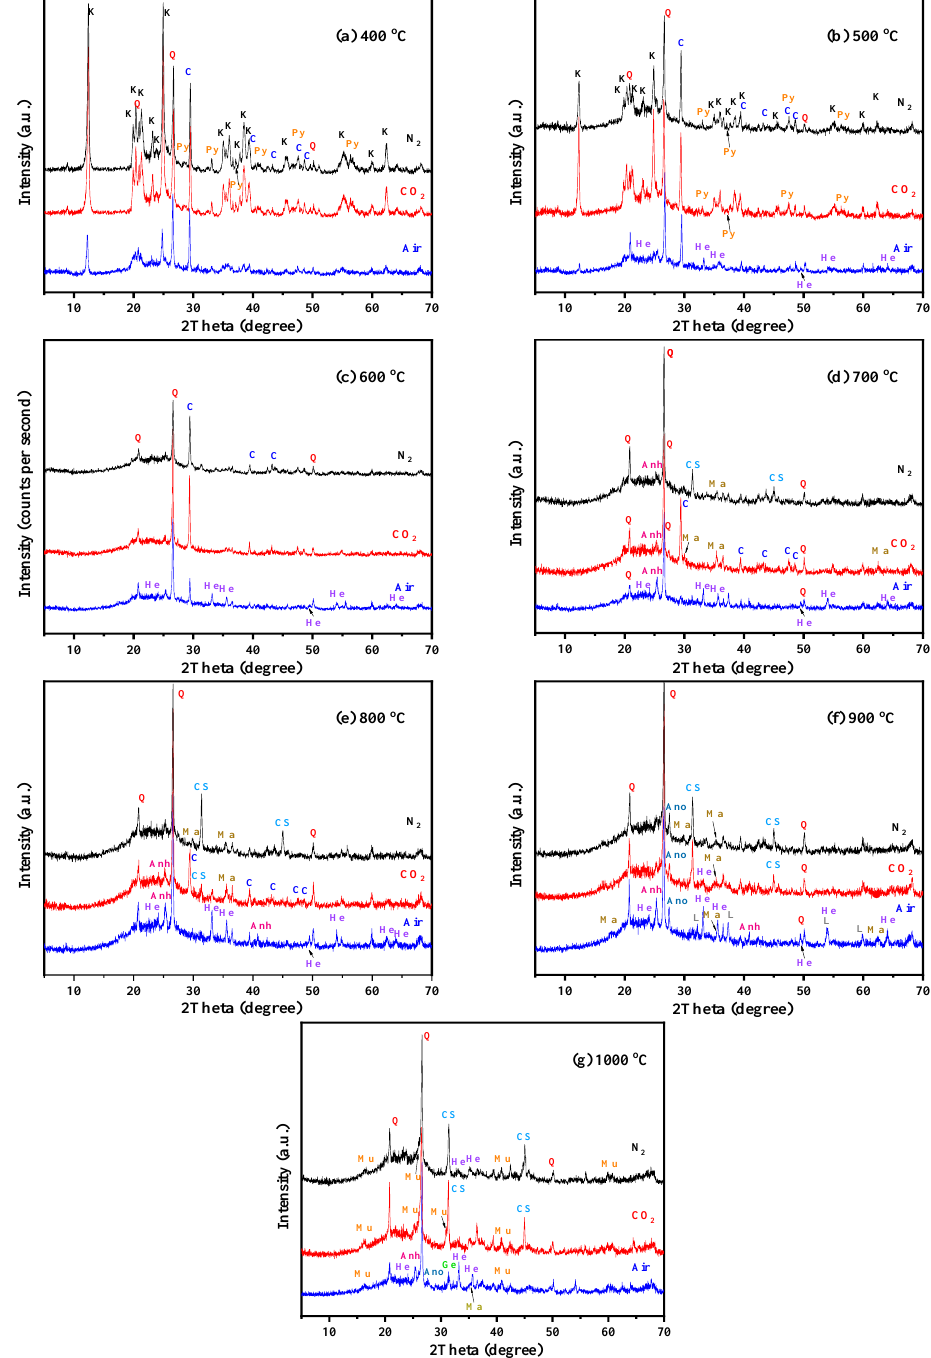
Figure 5. XRD pattern of the KAS calcined at 400 °C to 1000 °C under different atmospheres. ( a ) 400 °C, ( b ) 500 °C, ( c ) 600 °C, ( d ) 700 °C, ( e ) 800 °C, ( f ) 900 °C, ( g ) 1000 °C. (K — kaolinite, Q — quartz, C — calcite, Py — pyrite, He — hematite, Ma — magnetite, CS — calcium sulfate, Anh — anorthite, L — lime, Ge — gehlenite, Mu — mullite.)